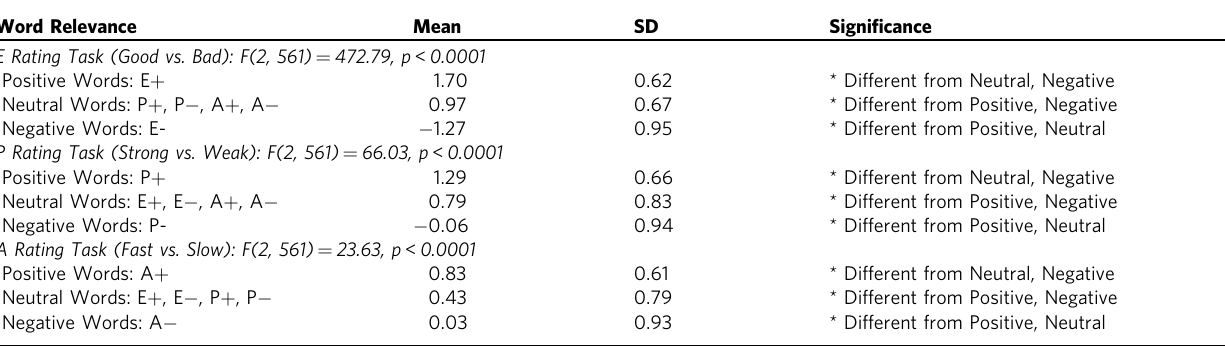
Table 2 Comparisons of word relevance (Positive Words, Neutral Words, Negative Words) within each rating Task (Evaluation, Potency,